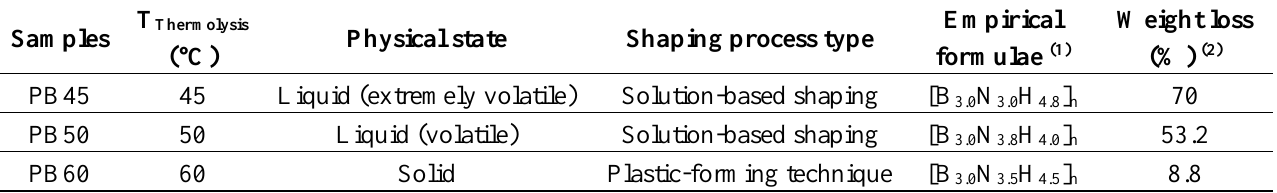
Table 1. Characteristics of the polyborazylenes produced by self-condensation of borazine in an autoclave under argon [57–59].